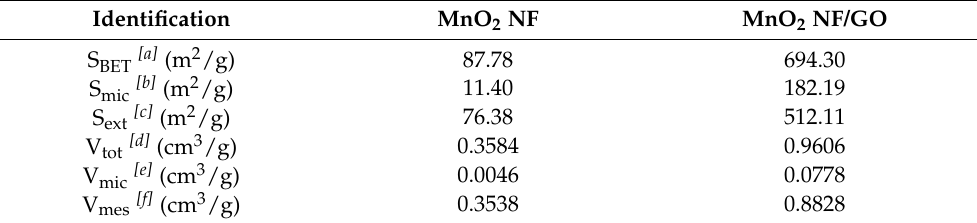
Table 1. Textural parameters of as-synthesized composites.